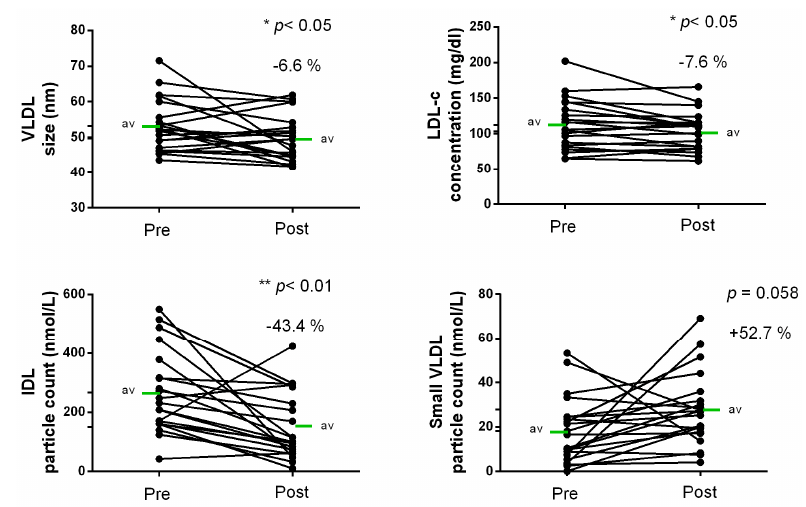
Figure 1. Graphical display of the significant results of Table 1. Twelve weeks of MIT ameliorates the lipoprotein profile of multiple sclerosis (MS) patients. Shown are individual observations, measured by NMR pre and post 12 weeks of medium-intensity training (MIT). * p < 0.05, ** p < 0.01.